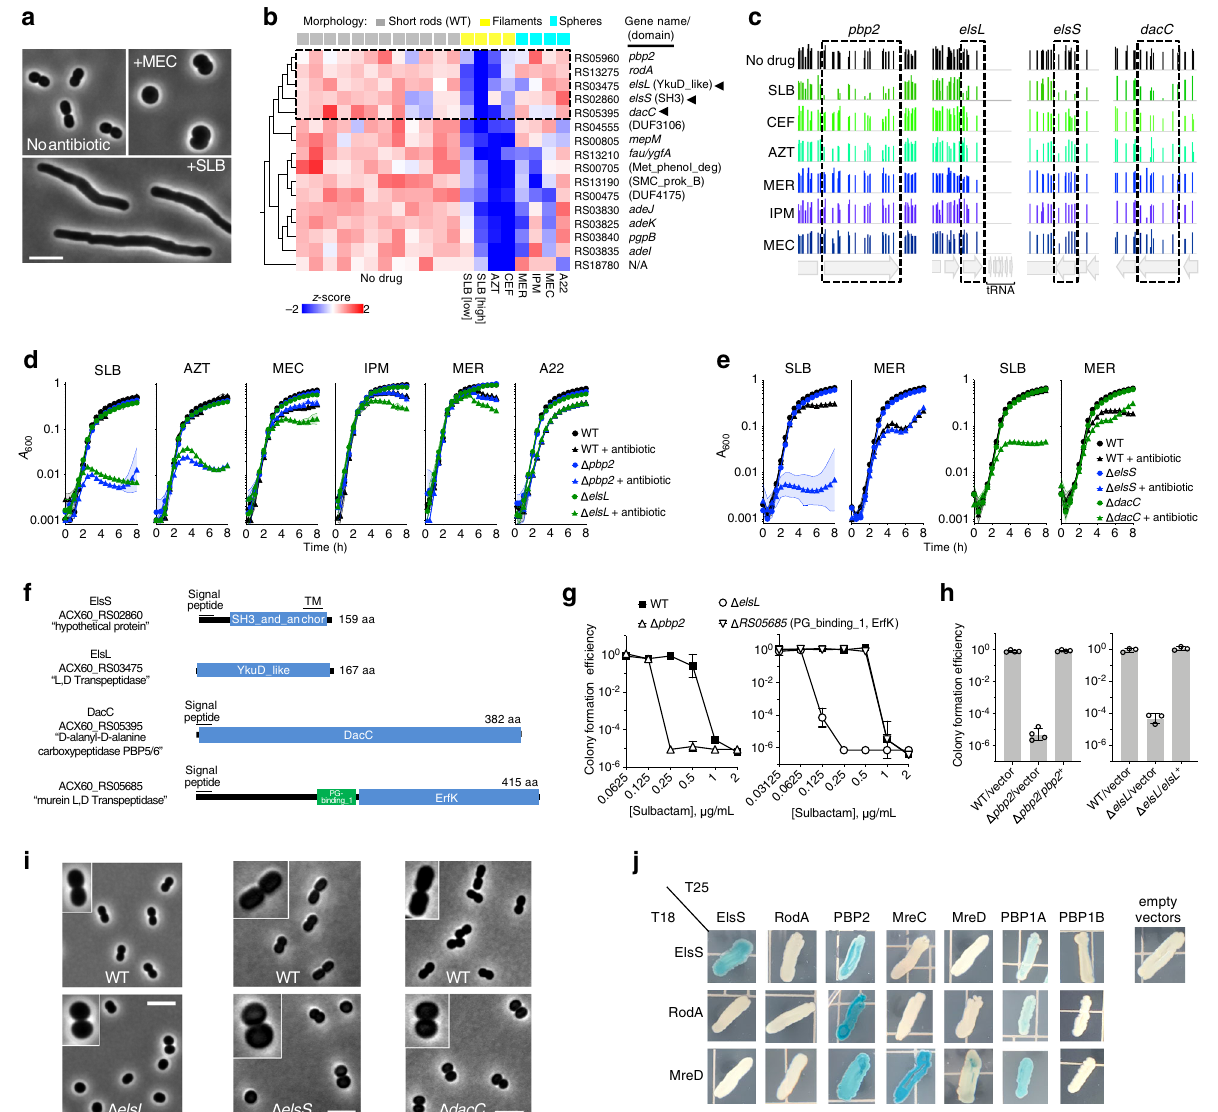
Fig. 5 Morphology-speci fi c susceptibility signatures uncover phenotypes and proteins linked to the Rod-system. a Exposure of A. baumannii to sub-MIC β -lactams causes target-speci fi c morphotypes. SLB (0.25 µ g/ml) causes growth as extended rods. CEF and AZT cause a similar fi lamentous morphology. MEC (16 µ g/ml) causes loss of rod shape. IPM and A22 cause a similar spheroid morphology. Images were acquired with phase-contrast. Scale bar, 5 µ m. b Tn-seq fi tness clusterogram showing subset of genes for which inactivation causes selective hypersensitivity to antibiotics generating fi laments vs. spheres. Tn-seq data from the indicated conditions were subjected to PCA using morphology annotations (indicated above the heatmap), and discriminating genes having signi fi cantly different fi tness with cell wall perturbations causing fi lamentation compared to other conditions were identi fi ed (two-sided t test, q = 0.025). Heatmap shows normalized fi tness in z -scored units. Dashed box indicates cluster of canonical Rod-system genes with three uncharacterized genes (arrowheads). c Fitness values of individual transposon mutants at each locus across all banks as in Fig. 3. d , e Validation of Tn-seq hypersensitivities using deletion mutants and WT cultured independently. Data points show geometric mean ± s.d. ( n = 3 independent cultures) as in Fig. 3. f Domain predictions in the indicated proteins, listed with NCBI locus tag and protein annotation. ElsL does not contain a predicted signal peptide. g SLB susceptibility on solid medium was analyzed via CFE assay. Data points show geometric mean ± s.d. (left, n = 3; right, n = 4 independent cultures). h CFE with SLB (0.25 µ g/ml) vs. no drug was measured with strains harboring pEGE305 (vector), pYDE135, ( pbp2 ) or pEGE308 ( elsL ). Bars show geometric mean ± s.d. (left, n = 4; right, n = 3 independent cultures). i ElsL, ElsS, and DacC determine Rod shape. Mutants (bottom) and WT control (top) grown without antibiotics to mid-log phase were imaged with phase contrast. Scale bar, 5 µ m. Images are representative of 2 ( elsL ), 3 ( elsS ), or 4 ( dacC ) parallel cultures. Insets show 2×-magni fi ed views of representative bacteria. j Two-hybrid interactions of ElsS and Rod-system proteins. Proteins fused to a T25 or T18 CyaA fragment were tested in E. coli for LacZ reporter activity on X-gal plates. Images are representative of 6 co-transformants patched in parallel. Source data are provided as a Source Data fi